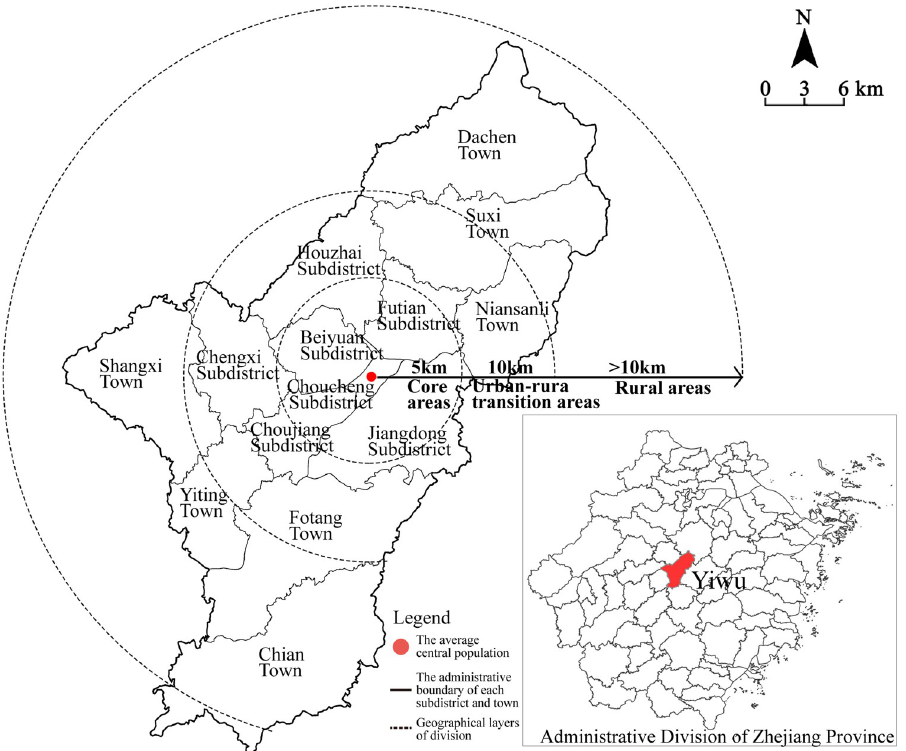
Fig 1. Research scope and layers of division. With the average central population of Yiwu city as the center, the study area was divided into three circles: core area, urban-rural integration area and rural area. Source: created by the author based on the base map of Yiwu which comes from the Open Street Map (OSM) geographic data platform (https:// www.openstreetmap.org/).